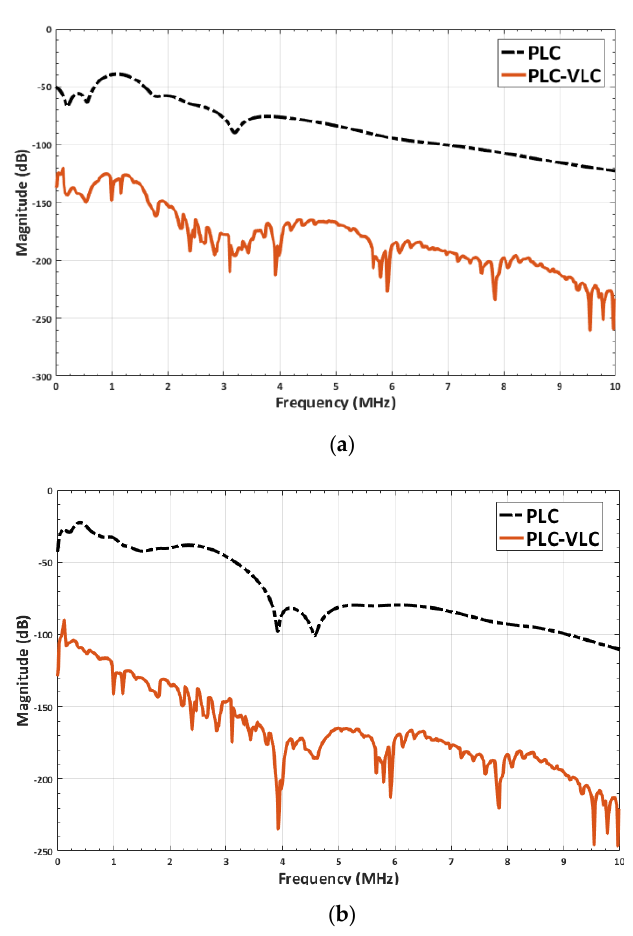
Figure 5. The results of different PLC network with their resulting IWOC-PLC channel: ( a ) 6 PLC taps network [11]; ( b ) 12 PLC taps network [11].